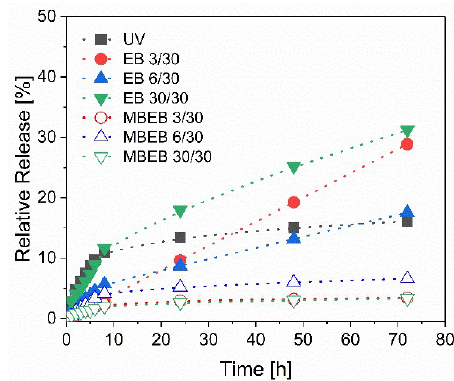
Figure 7. The methylene blue release of the hydrogels loaded reversibly (filled symbols) and irreversibly (empty symbols). MBEB: hydrogels with methylene blue incorporated before polymerization.